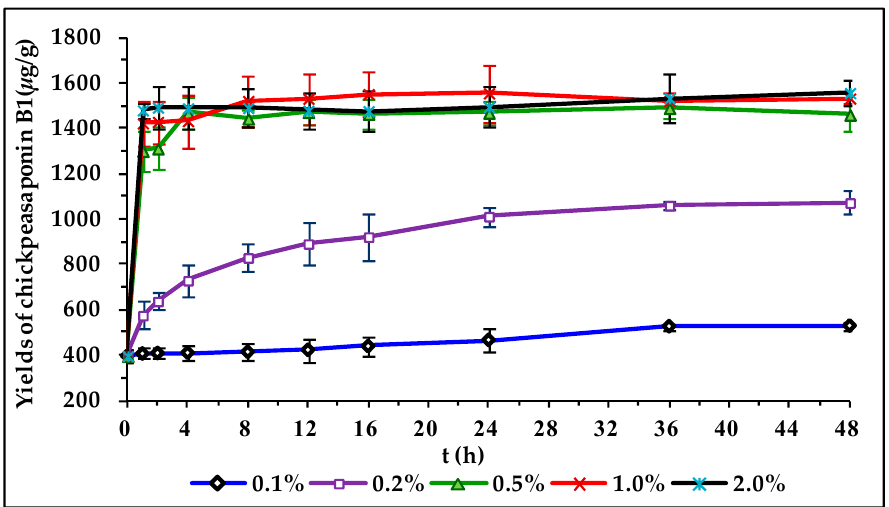
Figure 5. Hydrolysis dynamic curves of the total saponins of chickpea catalyzed by potassium hydroxide in 75% aqueous ethanol with different concentrations of 0.1%, 0.2%, 0.5%, 1.0%, 2.0%. Data are expressed as the mean value ± standard deviation (S.D.) of triplicate experiments.